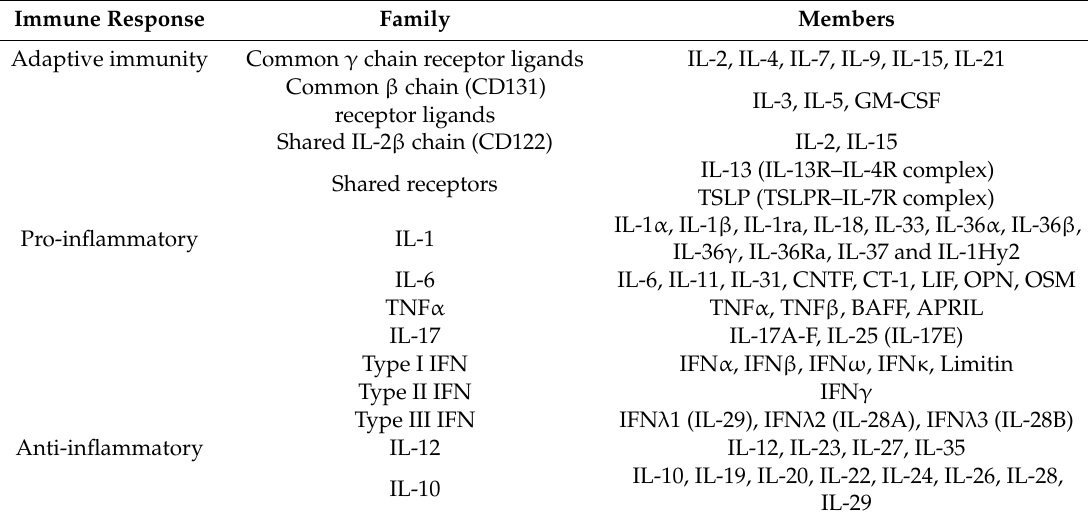
Table 1. Classification of cytokines based on their triggered immune response [4].